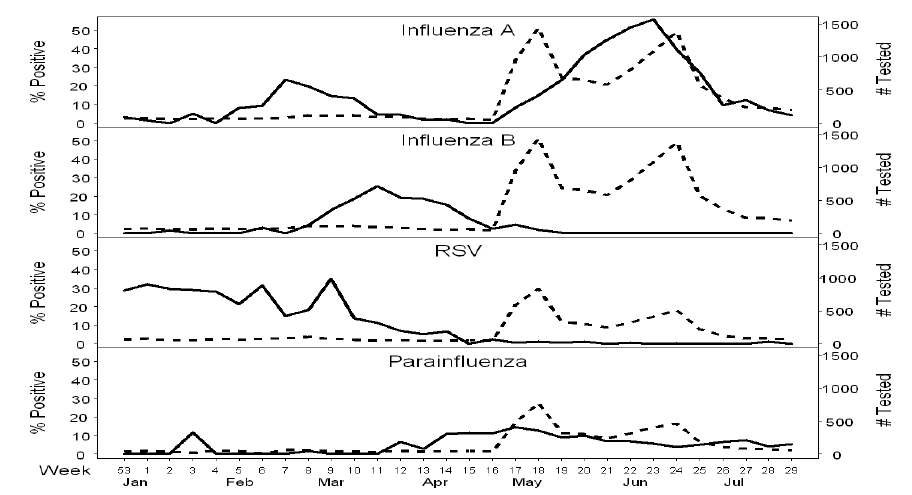
Figure 2. Respiratory virus activity over the 2008–2009 winter, spring and summer seasons by week in Milwaukee, Wisconsin. The total number of samples tested (depicted using dashed line) and percent positive (depicted using the solid line) are depicted for four viruses, detected using multiplex molecular